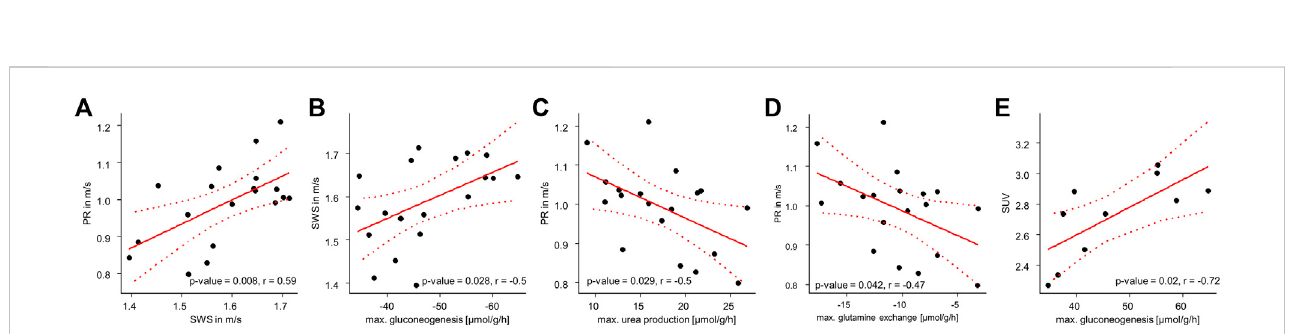
FIGURE 7 Correlation analysesofmetaboliccapabilitiesandMRE: (A) CorrelationbetweenSWSandPR; (B) SWSandgluconeogenesis; (C) PRandureaproduction; (D) PR and glutamine exchange and (E) SUV and gluconeogenesis. p - and r -values according to the linear regression model with n = 19 given in each panel. Red dotted lines indicate 95% con fi dence intervals of the linear